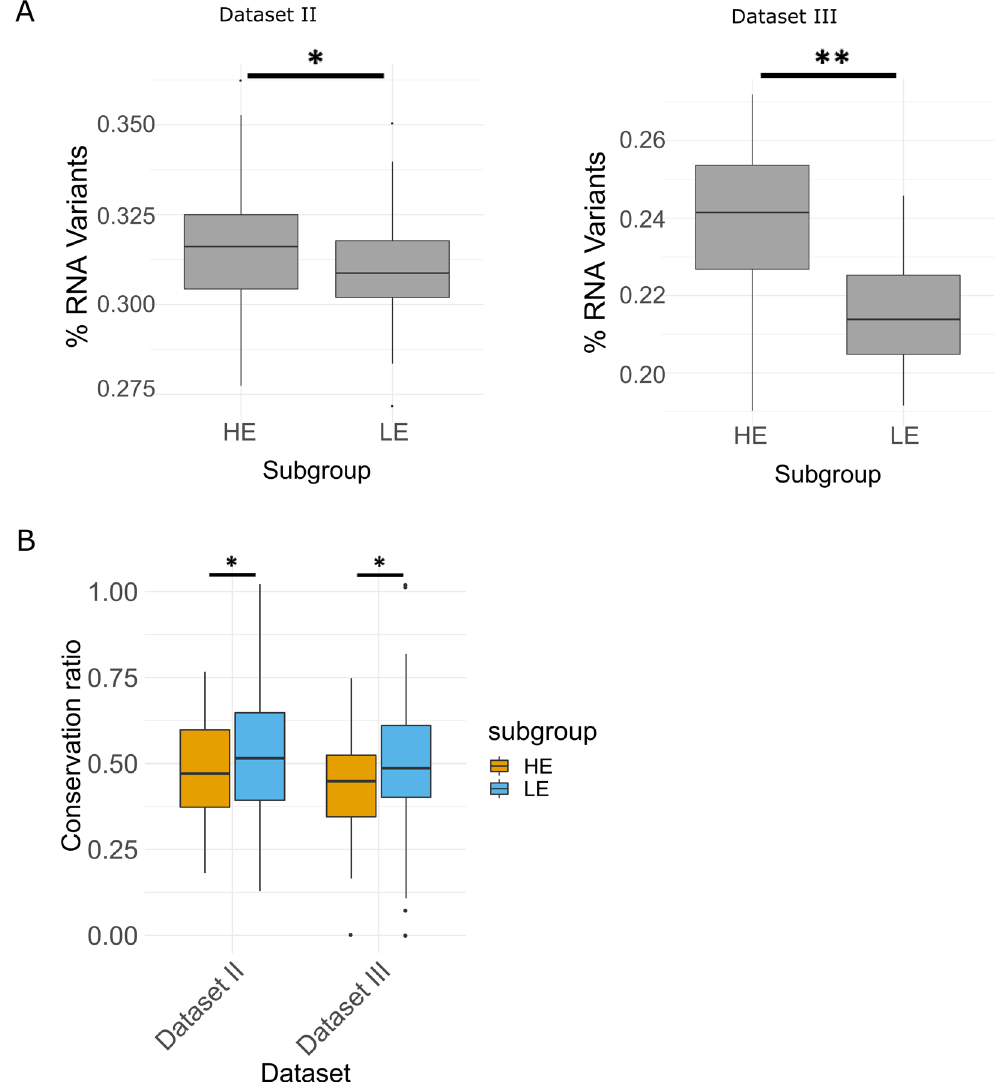
Figure 3. mtRNA mutation patterns display higher mutational repertoire and lower conservation score in the HE subgroup. ( A ) Box plot showing the comparison of the mutational repertoire in protein coding mtDNA genes between the two subgroups (LE and HE), per dataset (Datasets II and III). ( B ) Box plot demonstration of the distribution of evolutionary conservation ratios in mutations within the LE and HE groups, per analysed